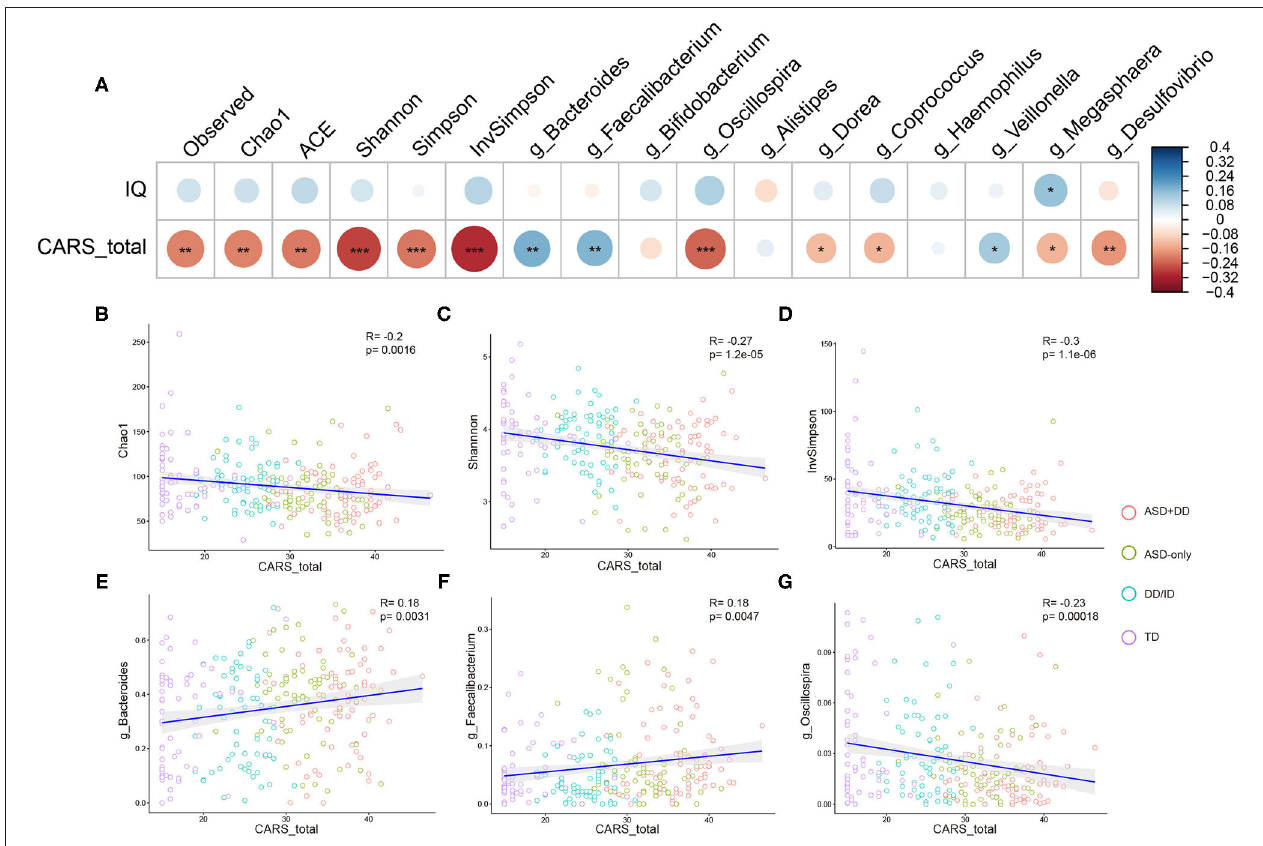
FIGURE 4 | Correlation between alpha diversity, microbiota genera, and clinical parameters in all participants. Heatmaps showing association between alpha diversity, microbiota composition, and clinical characteristics (A) . * p < 0.05 and ** p < 0.01. Total CARS score is negatively correlated with Chao1 index (B) , Shannon index (C) , InvSimpson index (D) in all participants. Genus Bacteroides (E) , genus Faecalibacterium (F) , and genus Oscillospira (G) based on the OTU profile were associated with CARS total scores. * p < 0.05, ** p < 0.01, and *** p <